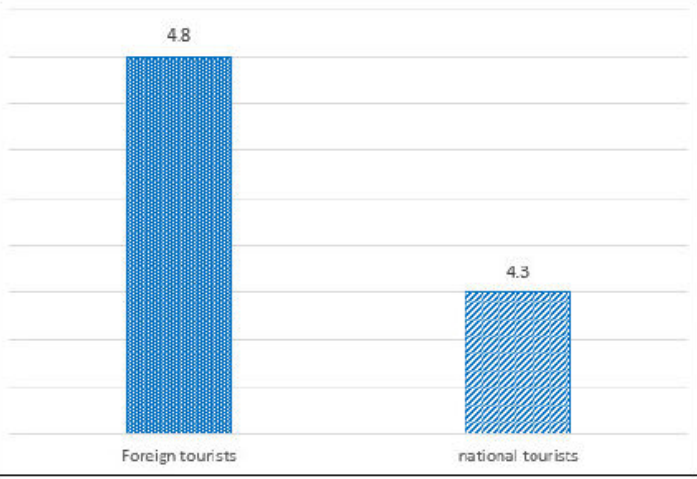
Figure 9. General situation of the preferences of foreign and domestic tourists for the tourist product. Source: own elaboration based on the results of the survey of the preferences of